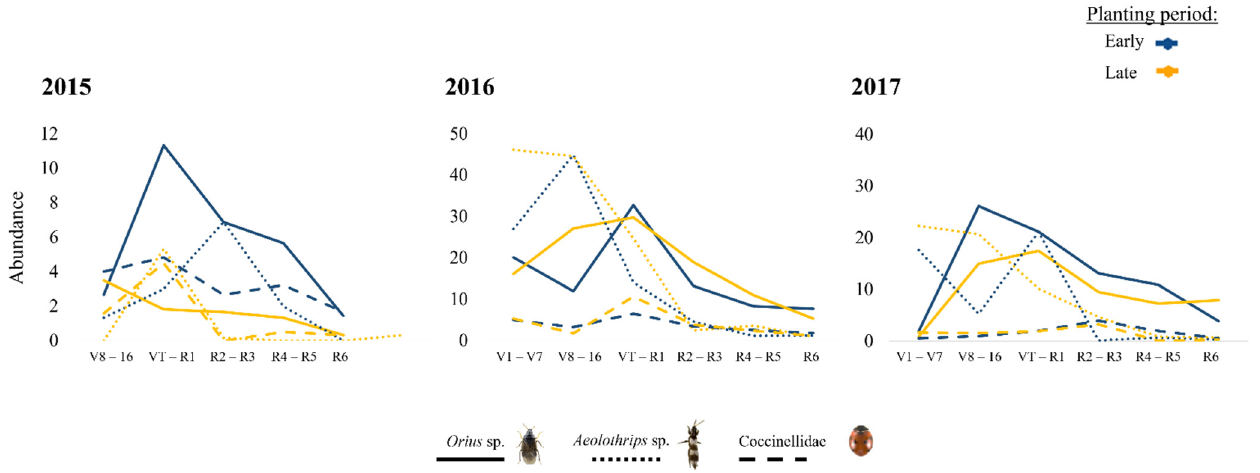
Figure 4. Natural enemy abundance according to the maize phenology each year in each planting period (blue line = late; yellow line = early). Only the species that had significant differences ( p < 0.05) according to the analyses are shown. (More details in Supplementary material).